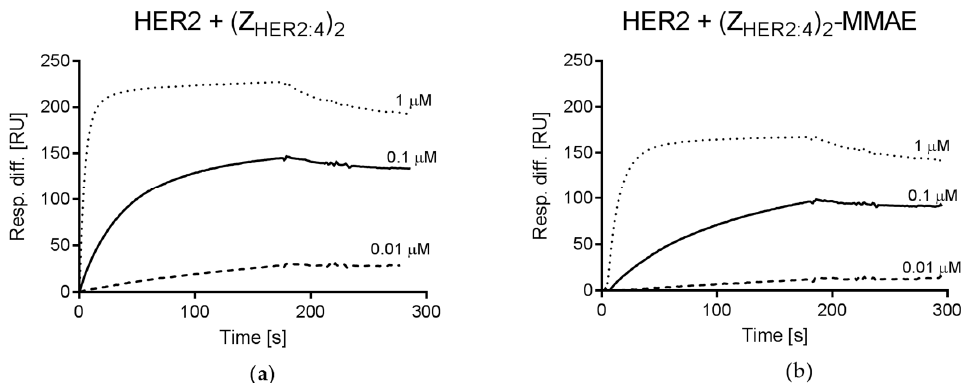
Figure 6. Surface plasmon resonance (SPR) analysis of HER2 and diaffibody interaction was performed using ( a ) increasing concentrations of 0.01, 0.1, and 1 μ M of the diaffibody; and ( b ) the diaffibody-MMAE conjugate. The y axis represents the response difference in relative units (RU).